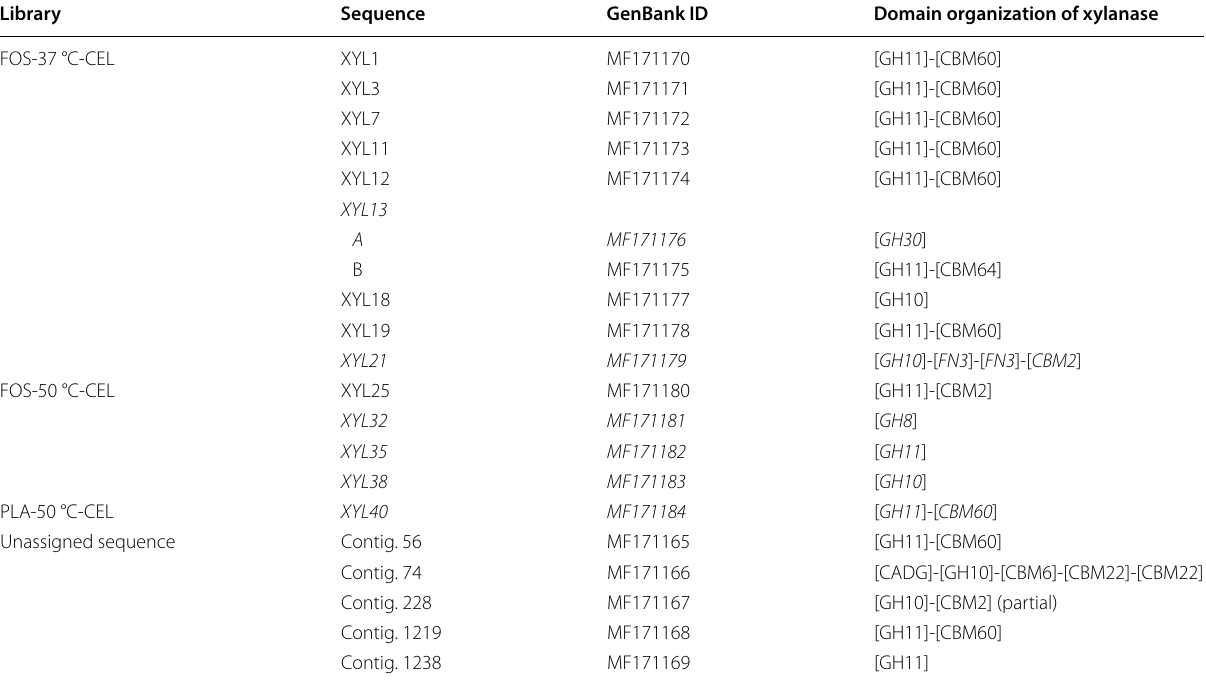
Xylanase domain structure is indicated using the abbreviations of families of glycosyl hydrolases (GH) and carbohydrate-binding modules (CBMs) in brackets. The genes selected for subcloning and further study are indicated in